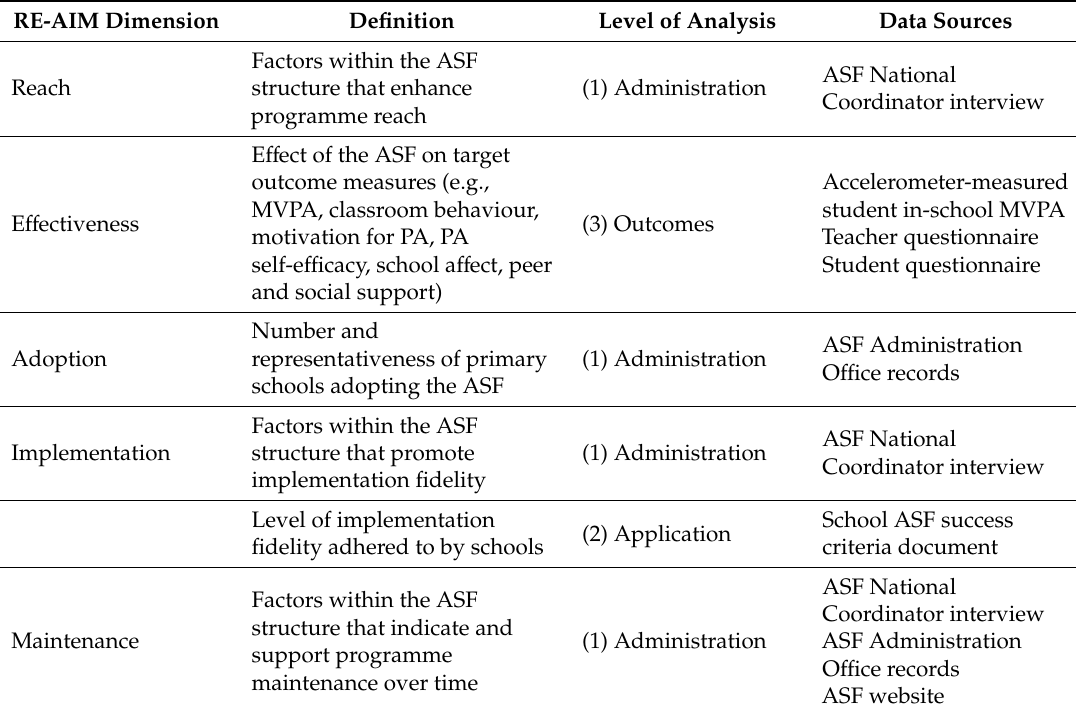
Table 1. Definitions and data sources for each of the RE-AIM